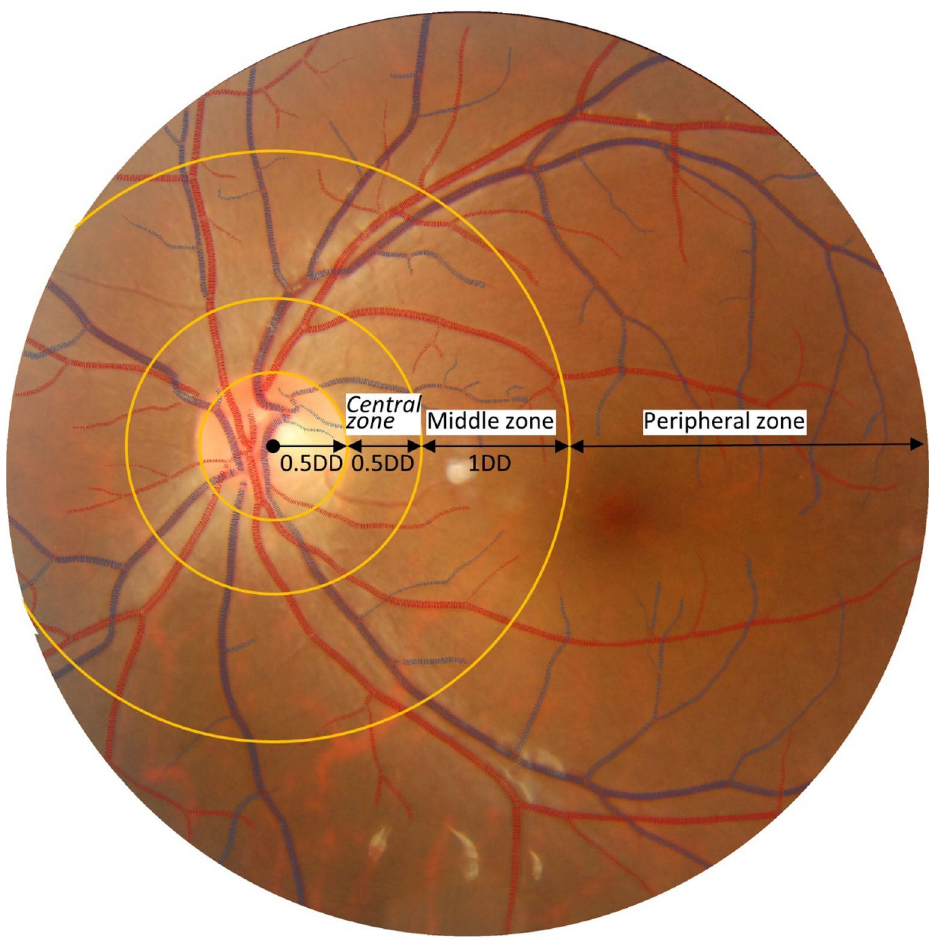
Figure 1. Sample image showing the vascular caliber measurements. Centered at the optic disc, blood vessels were categorized into three concentric zones: central zone (0.5–1.0 DD), middle zone (1.0–2.0 DD), and peripheral zone (> 2.0 DD). The averaged arteriolar and venular calibers were calculated in each zone and denoted as aCtr , aMdl , aPeri , vCtr , vMdl , and vPeri ,